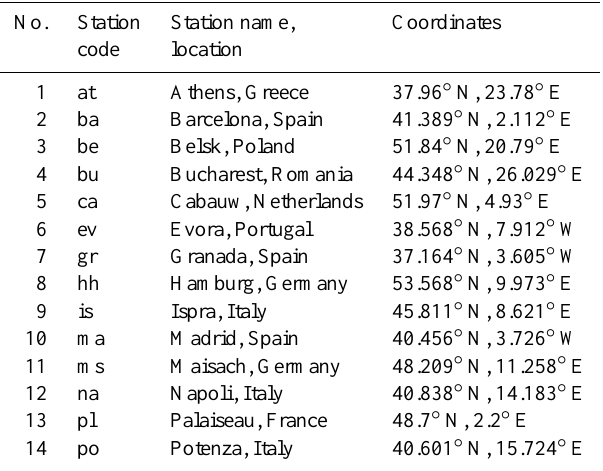
Table 1. EARLINET stations that had coincident measurements with CALIOP during the observational period (Pappalardo et al., 2014).